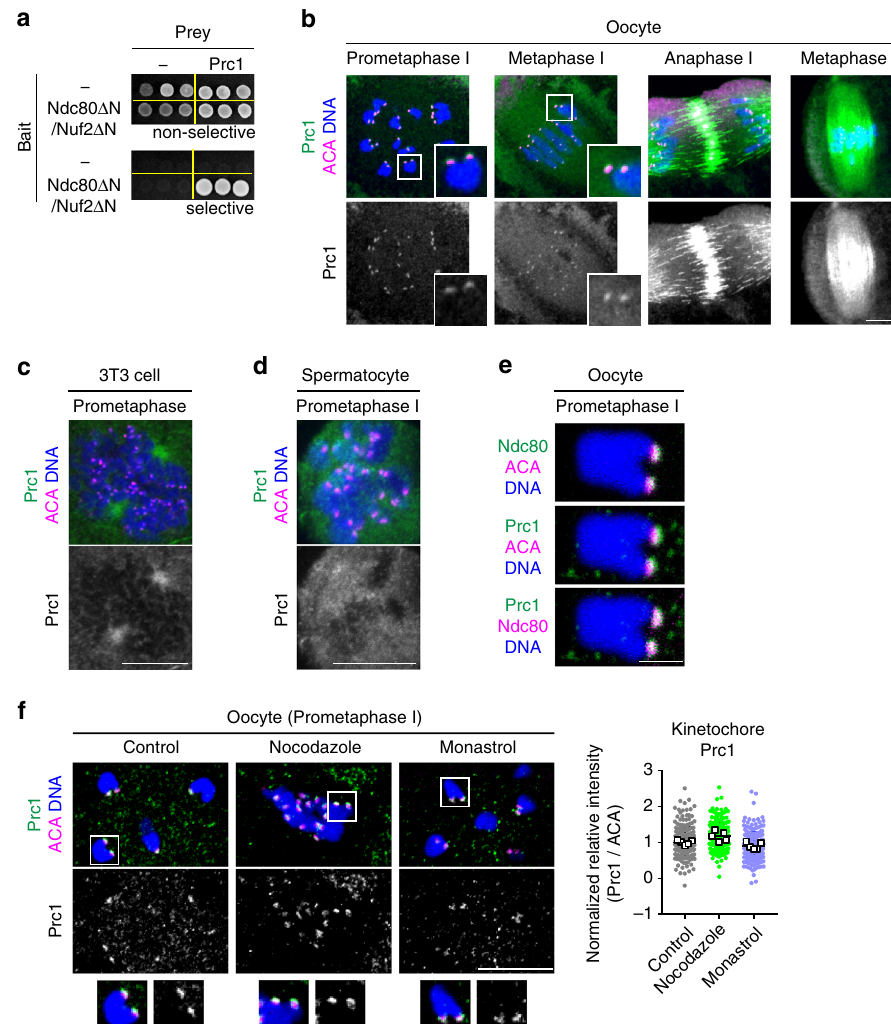
Fig. 2 Ndc80/Nuf2 interacts with the antiparallel microtubule crosslinker Prc1 at kinetochores. a Prc1 can interact with Ndc80 Δ N/Nuf2 Δ N. Yeast two- hybrid assay using Ndc80 Δ N fused with a DNA-binding domain, Nuf2 Δ N, and Prc1 fused with a transcription activation domain. Selective ( − His, − Ade) and nonselective ( + His, + Ade) plates were used. b Prc1 localizes to kinetochores. Z-projection images of oocytes stained for Prc1 (green), kinetochores (ACA, magenta), and DNA (Hoechst33342, blue) are shown. Prc1 signals at kinetochores are magni fi ed. One of the z-slice images at metaphase II is shown in Supplementary Fig. 6g. More than three independent experiments were performed. c Prc1 is not enriched at kinetochores at mitotic prometaphase in centrosomal cultured cells. NIH3T3 cells were stained for Prc1 (green), kinetochores (ACA, magenta), and DNA (Hoechst33342, blue). Three independent experiments were performed. d Prc1 is not enriched at kinetochores at meiotic prometaphase I in centrosomal spermatocytes. Spermatocytes were stained for Prc1 (green), kinetochores (ACA, magenta), and DNA (Hoechst33342, blue). Three independent experiments were performed. e Prc1 colocalizes with Ndc80. Oocytes expressing Ndc80-sfGFP at prometaphase I (2 h after NEBD) were immunostained with anti-GFP, anti- Prc1, and ACA antibodies. DNA is counterstained with Hoechst33342 (blue). Magni fi ed images show that Prc1 is located closer to Ndc80 than to ACA. Three independent experiments were performed. f Prc1 localizes to kinetochores independently of microtubule attachment and spindle bipolarization. Oocytes were treated with nocodazole or monastrol at 1.5 h after NEBD, incubated for 30 min, and immunostained for Prc1 (green), kinetochores (ACA, magenta), and DNA (Hoechst33342, blue). Prc1 signals at kinetochores are magni fi ed. The kinetochore ratios of the Prc1 signals to the ACA signal are shown. Spots and squares correspond to individual kinetochores and oocytes, respectively ( n = 200, 200, 198 kinetochores from 5, 5, 5 oocytes). Three independent experiments were performed. Mean + / − SD are presented. Scale bars; 10 μ m ( b ), ( c ), ( d ), and ( f ); 2 μ m ( e